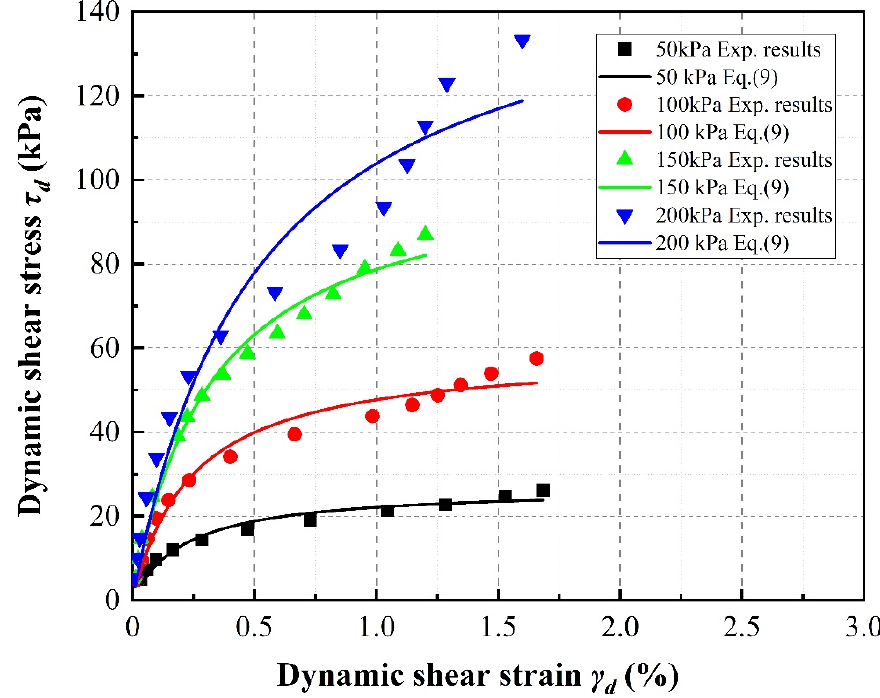
Figure 8. Effect of confining pressure on stress–strain relationships of SRP2 sand–rubber mixtures with 20% rubber content.